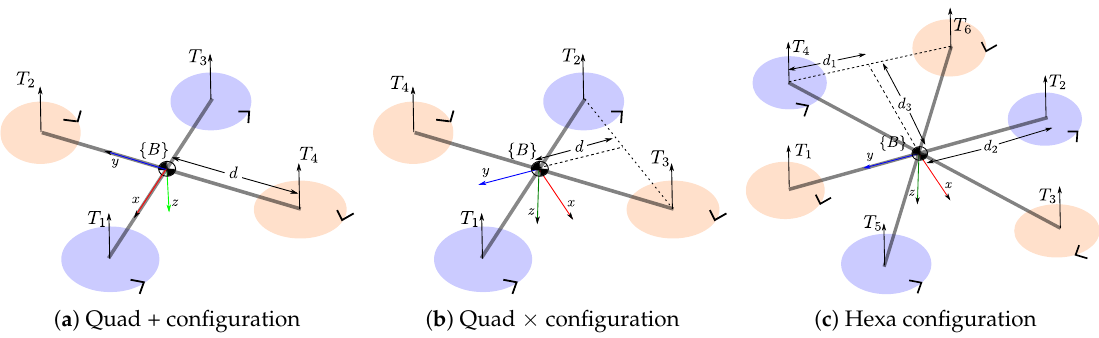
Figure 1. Notation for three common classes of multi-rotor UAV showing their rotors, thrust vectors, and direction of